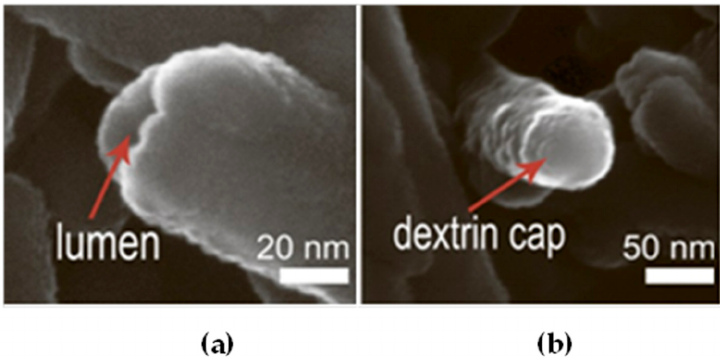
Figure 5. SEM images of ( a ) an open halloysite lumen, ( b ) a dextrin capped halloysite lumen. Reproduced from [67] under Creative Commons Attribution 4.0 International License.